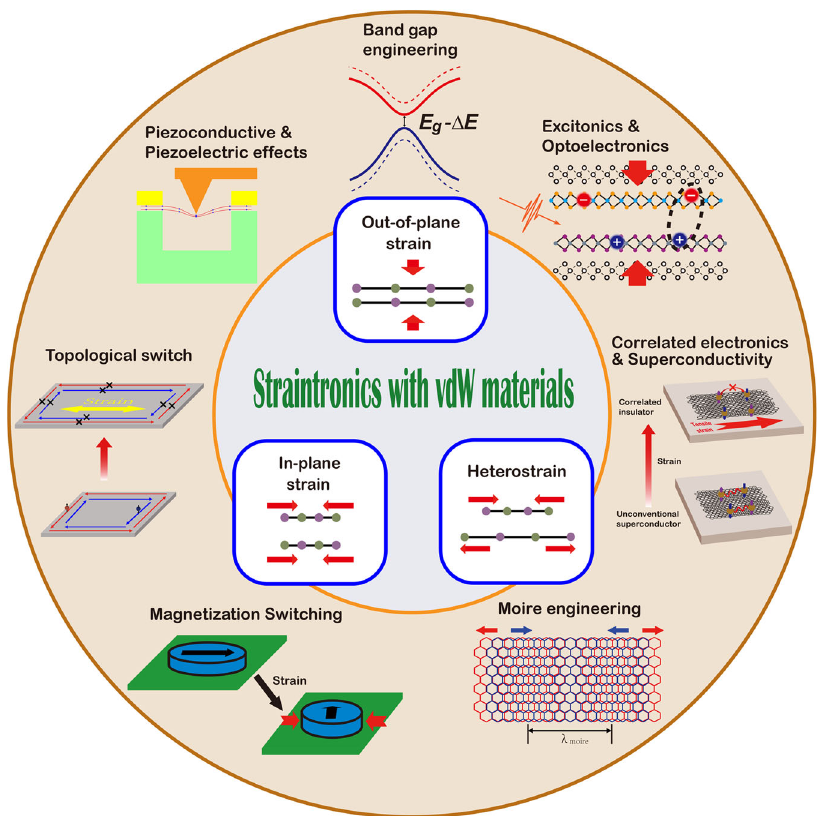
Fig. 1 Summary of straintronics with vdW materials. The strain engineering on vdW materials can be classi fi ed into in-plane strain, out-of- plane strain, and heterostrain. Related directions for the future research in this fi eld are